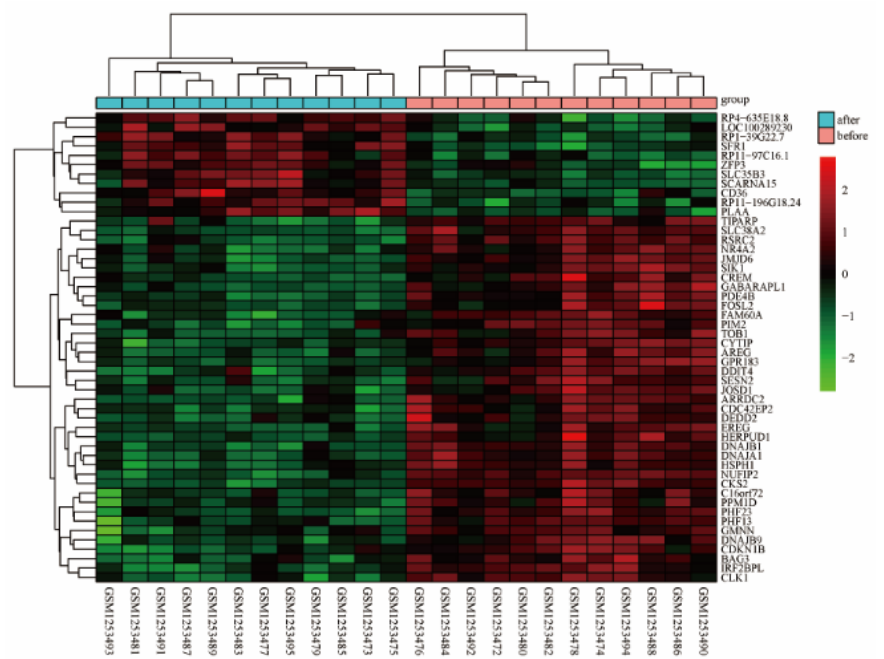
Figure 3. Hierarchical clustering heat map of the top 50 DEGs. Red indicates that gene expression is relatively upregulated, green indicates that gene expression is relatively downregulated, and black indicates no significant changes in gene expression.